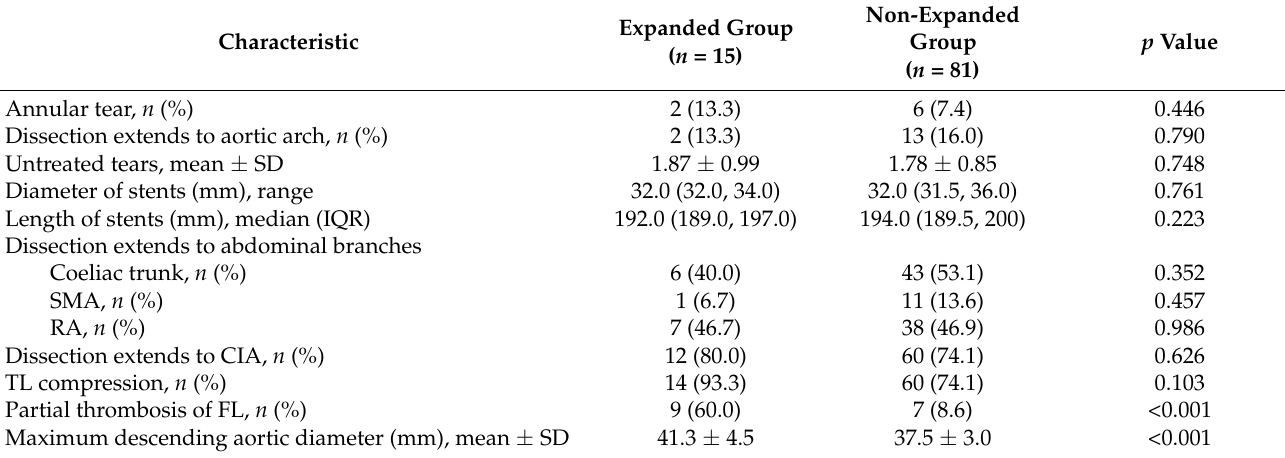
Table 2. Imaging features of 96